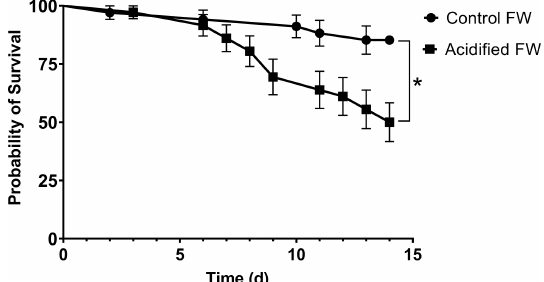
Figure 1. Survivorship curves of juvenile Chinese mitten crab, Eri- ocheir sinensis , over 14d of exposure to control (pH 7.4, 1364µatm p CO 2 ) or CO 2 -acidified (pH 6.8, 4633µatm p CO 2 ) freshwater. Data are presented as probability of survival ± SEM ( N = 34 for control freshwater and N = 36 for acidified freshwater). Statistical significance was assessed by a Mantel–Cox test, with ∗ indicating significant difference between probability of survival between con- trol and freshwater acidified crab